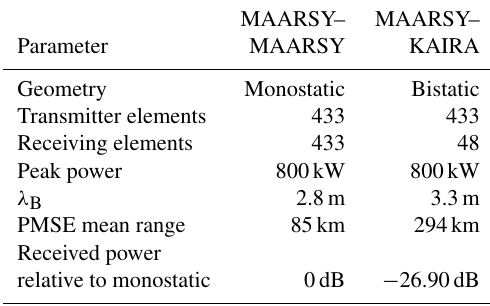
Table 1. Experimental parameters over MAARSY.